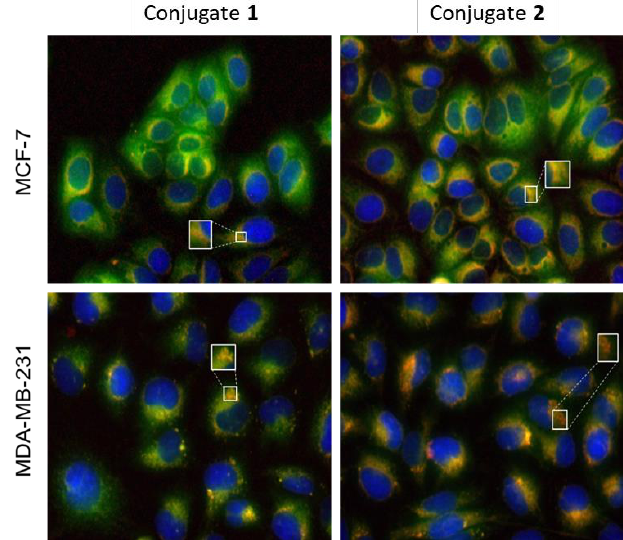
Figure 8 . Co-localization of estradiol-BODIPY conjugates 1 and 2 in MCF-7 and MDA-MB-231 breast cancer cells after 6 h of incubation. Cells were stained with Hoechst 33258 (nucleus marker) and LAMP-2 (lysosome marker), and images were acquired with an inverted microscope at magnification 400×. Images were treated using Image J software version 1.53c (National Institutes of Health (NIH), Bethesda, MD, USA). The images are the merged results of images acquired in the different channels (Figure S9). White boxes are the amplification of intracellular regions.